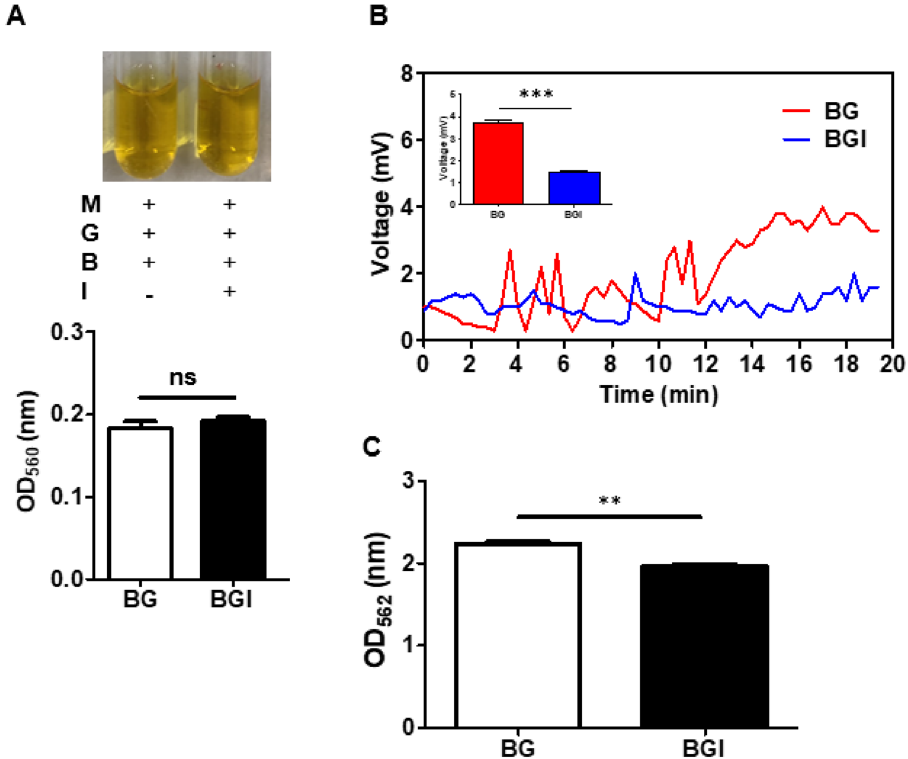
colour change of phenol red in media from red to yellow indicated fermentation still occurred. Furthermore, fermentation was quantified by measuring the optical density of phenol red at OD560. ( B ) Voltage